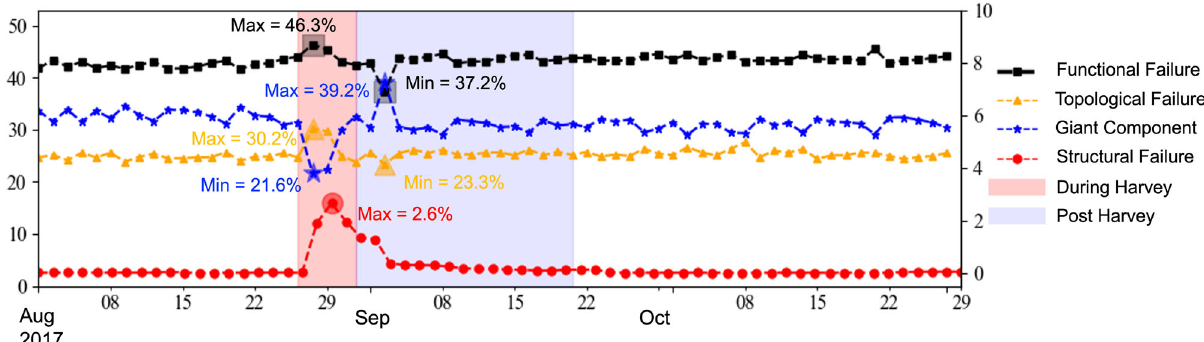
Fig. 2 Time series of individual failures and their evolution over the course of Hurricane Harvey. We use q = 0.8 for the illustrative purpose. The average failure before Harvey for each failure is a functional failure (42.3%) in black square solid line, topological failure (24.8%) in yellow triangle dash line, giant component (32.9%) in blue star dash line, and structural failure (0%) in red dot-dash